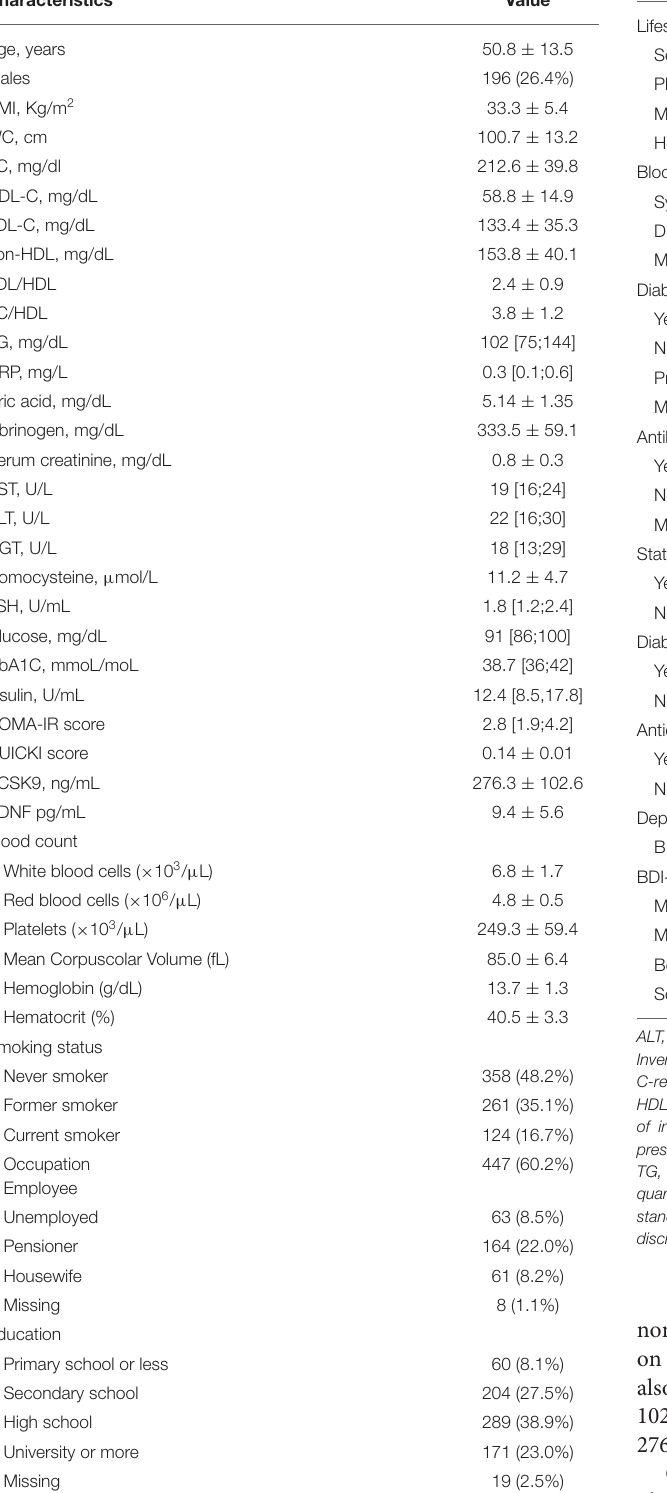
TABLE 1 | Demographic and clinical characteristics of the study participants ( N = 743).